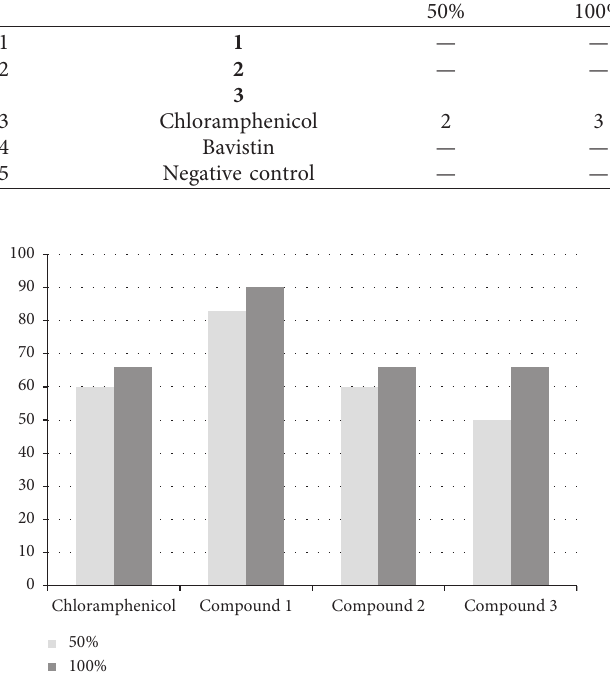
Figure 3: Comparison of % of bioactivity: chloramphenicol drug with compounds 1–3